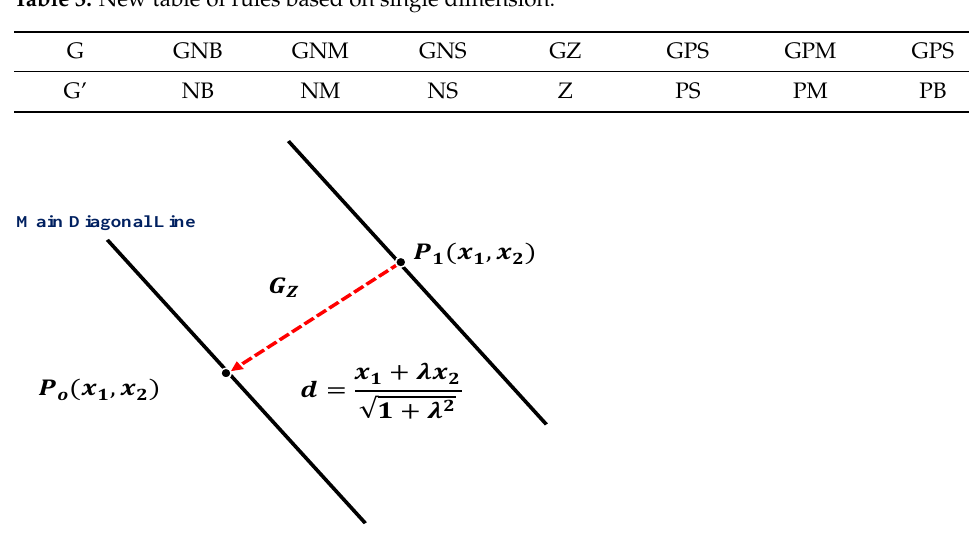
Figure 6. Graphical illustration for diagonal variable G.